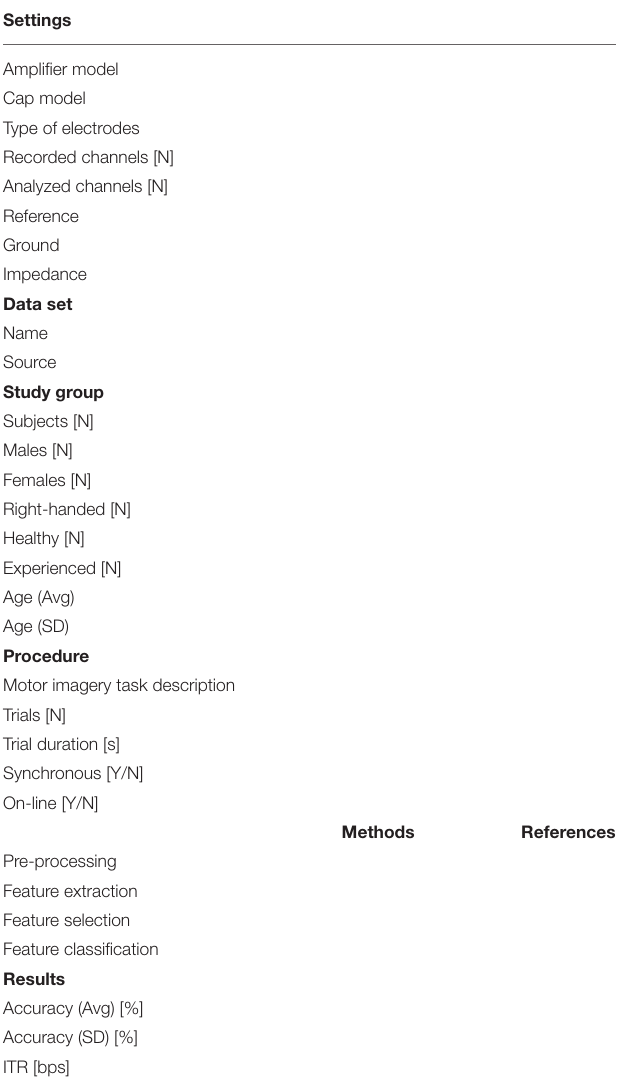
TABLE 3 | The sample design of table that could be used to summarize relevant information about a study.